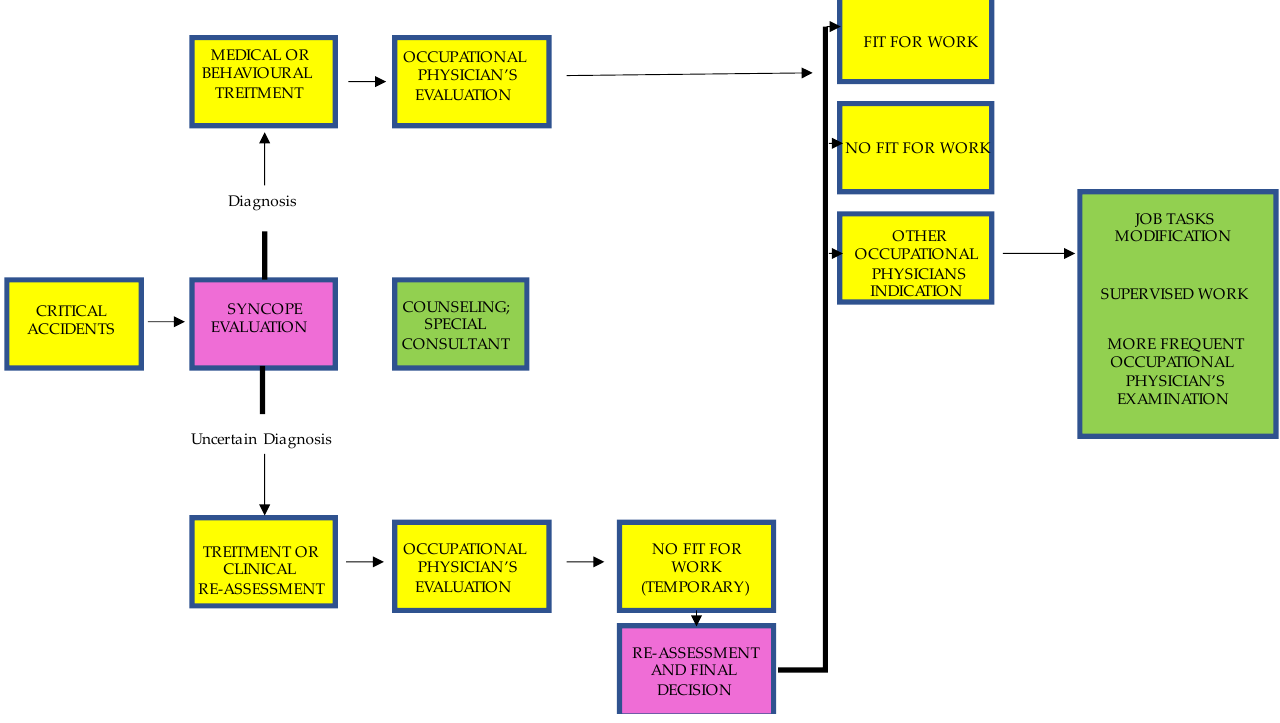
Figure 1. Fitness for work of employees affected by syncope and engaged in high-risk job tasks.